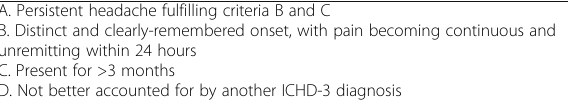
Table 2 (abstract P116). ICHD-3 diagnostic criteria for NDPH